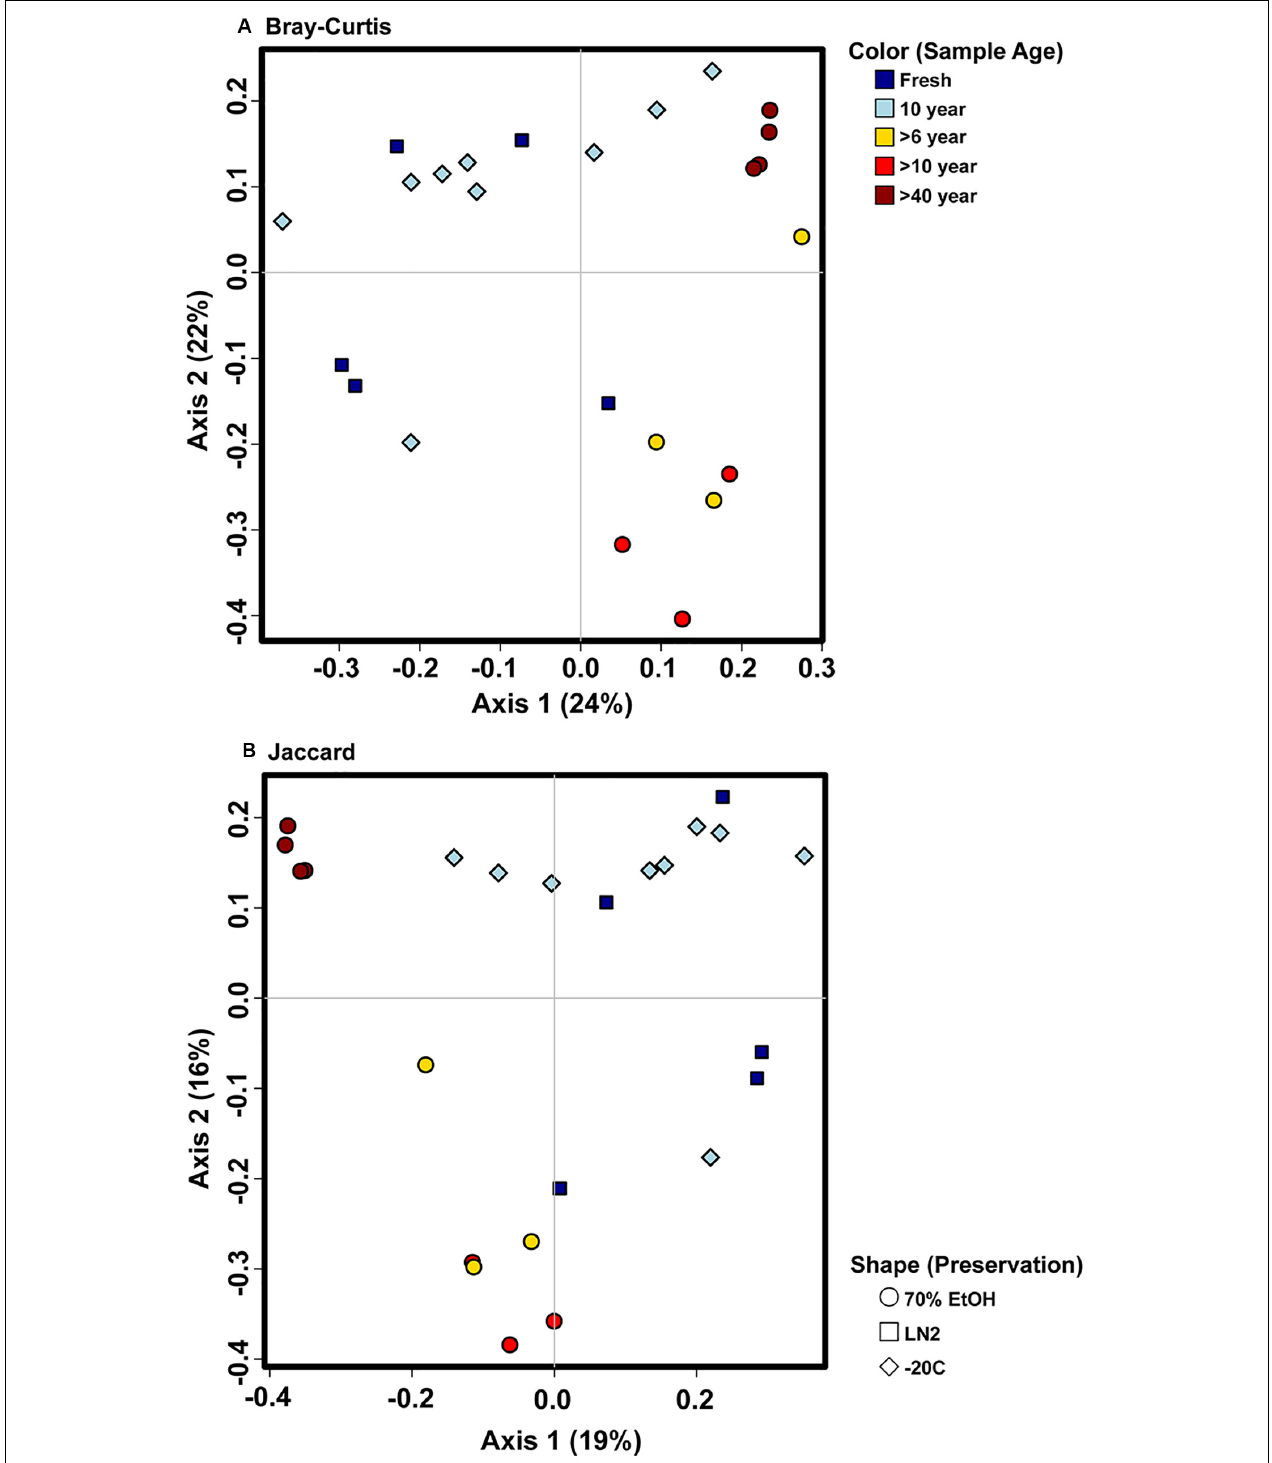
FIGURE 7 | Principal coordinate analysis plots of ASV based (A) Bray-Curtis and (B) Jaccard distances depicting bacterial beta diversity of intestinal samples of varying age and preservation. Color indicates the sample age, while shape indicates the preservation type.